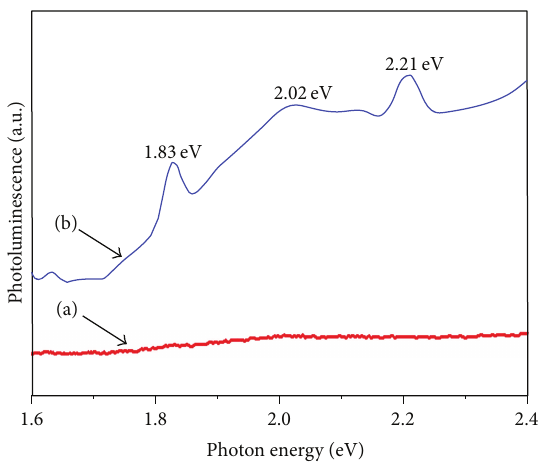
Figure 5: Photoluminescence spectra of the as-obtained glasses: (a) pure glass and (b) AgInS 2 nanocrystals